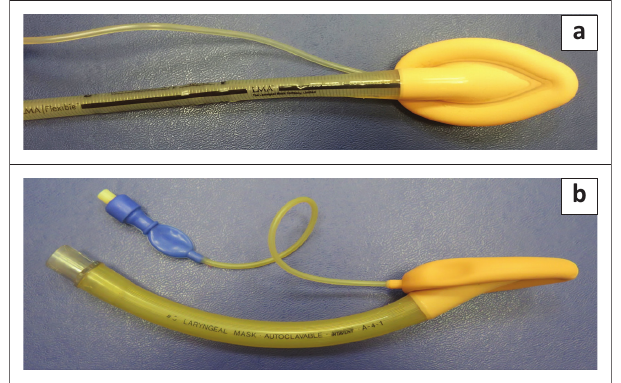
FIGURE 5: Laryngeal mask airway devices (first generation).